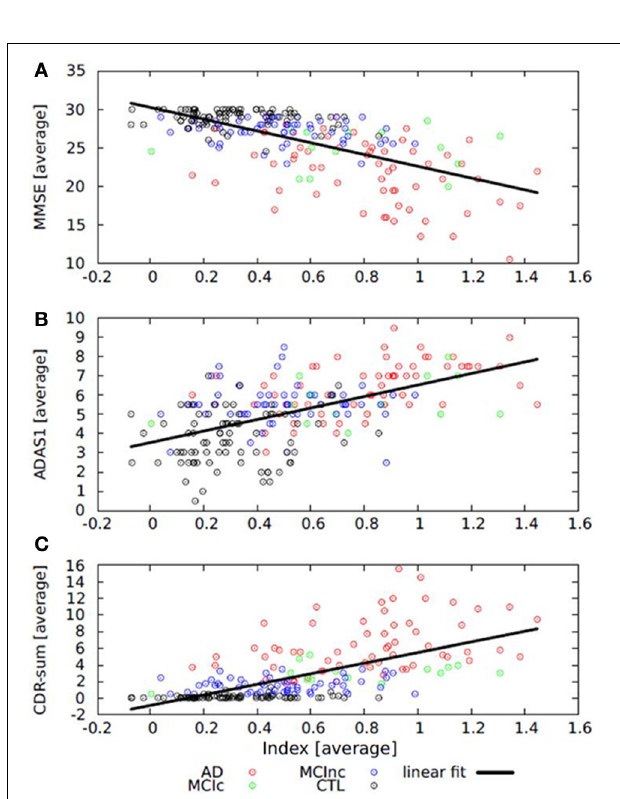
FIGURE 6 | Scatter plots and regression lines showing the relationship between (A) average index and average MMSE; (B) average index and average ADAS1, and (C) average index and average CDR-sum. Average index = (average index at baseline + average index at 1-year)/2. MMSE, Mini Mental State Examination; CDR-sum, Clinical Dementia Rating sum of boxes; ADAS1, Alzheimer Disease Assessment Scale.